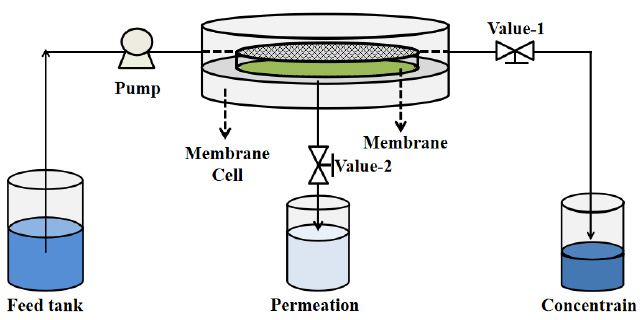
Scheme 2. Schematic diagram of cross-flow filtration for O/W emulsion